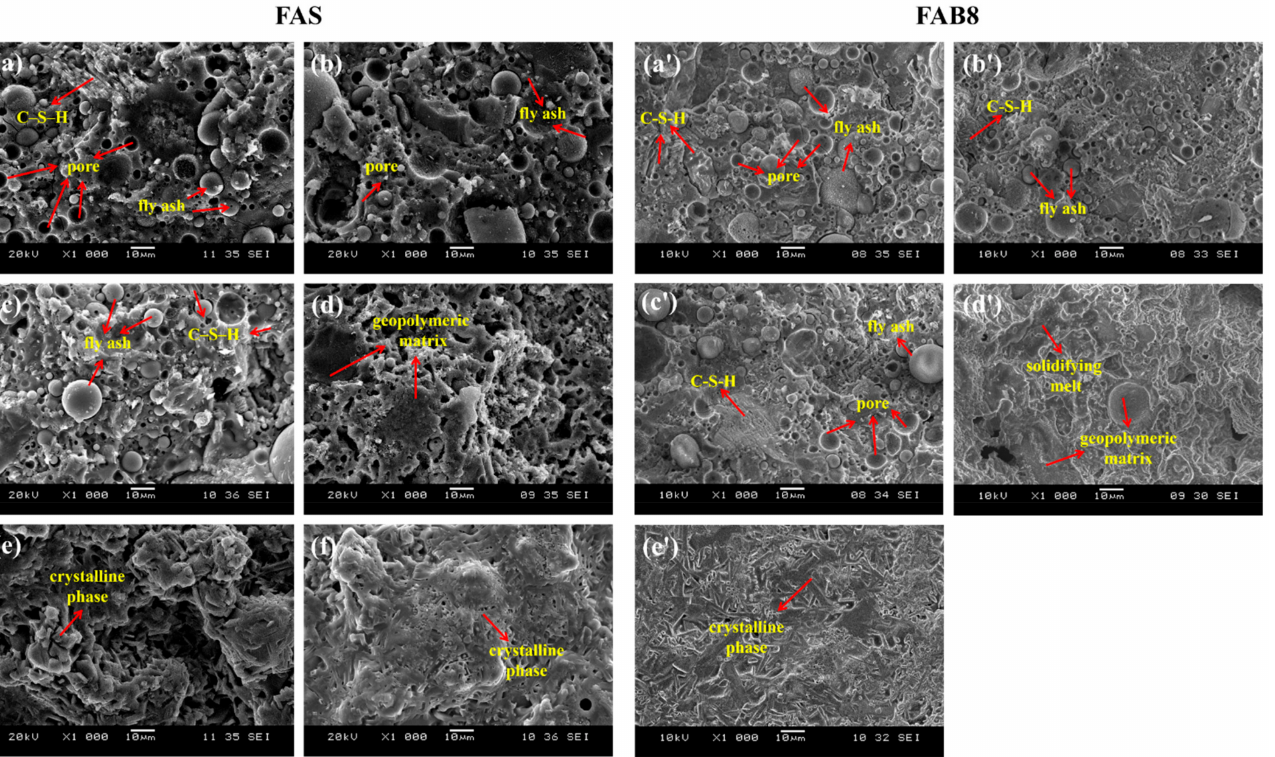
Figure 10. SEM micrographs of FAS ( left ) and FAB8 ( right ) geopolymers exposed to elevated temperature of ( a , a (cid:48) ) RT; ( b , b (cid:48) ) 300 ◦ C; ( c , c (cid:48) ) 600 ◦ C; ( d , d (cid:48) ) 900 ◦ C; ( e , e (cid:48) ) 1000 ◦ C and ( f ) 1100 ◦